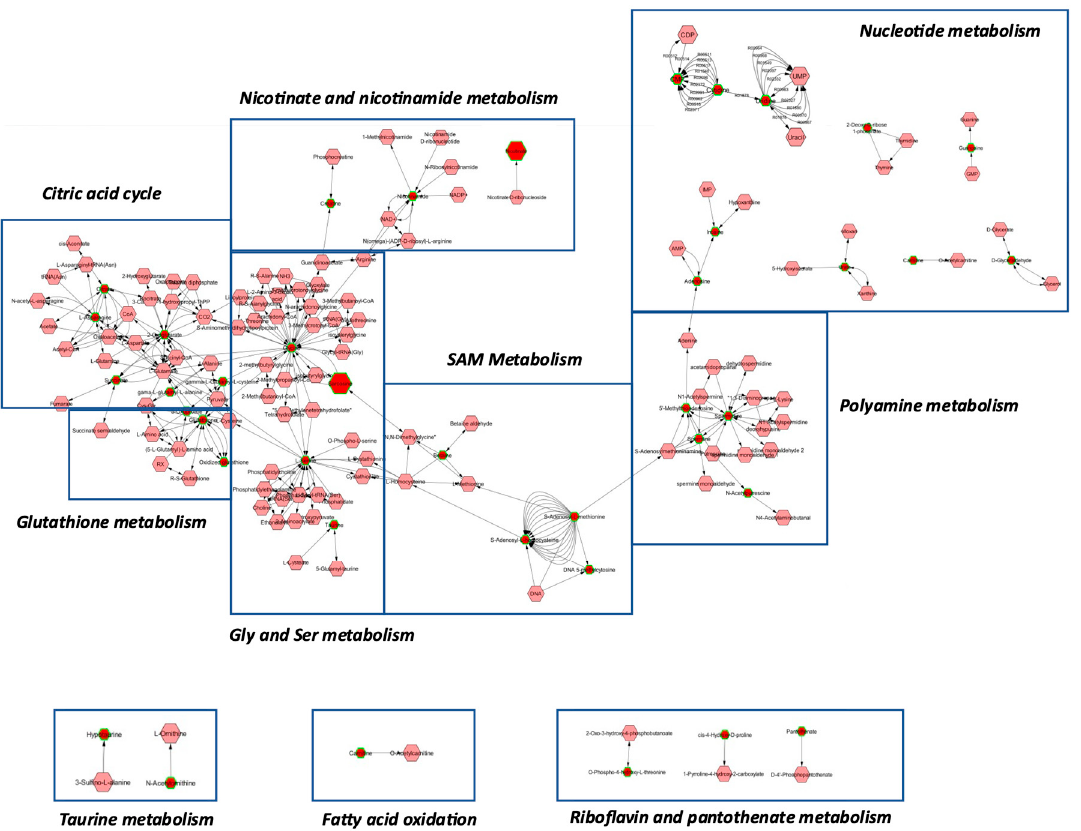
Figure 7. ALDH1L1-dependent metabolic network constructed based on comparison between WT group and combined group of ALDH1L1 targeted cells. OL1 and OL2a level metabolites were uploaded to Metscape with p-values and fold changes. Metabolites were organized into pathways using the KEGG human database. Dark red nodes with green outline are metabolites significantly different between WT and all KO groups (FDR-corrected p < 0.05). Light red nodes are metabolites included in the KEGG database for these pathways, which differences were not significant between WT and all KO groups in our experimental data. The size of the nodes indicates the direction of change—small nodes are decreased in KO samples whereas large nodes are increased. Edges represent known enzymatic reactions in the database that connect two